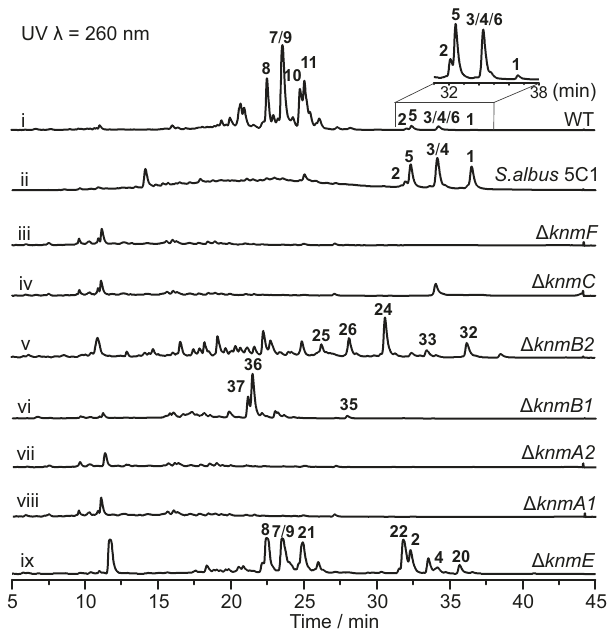
Fig. 2 | HPLC analysis of metabolic extracts from wild-type L. rhizosphaerae NEAU-A2 (i, magni fi ed region focuses on 1 – 6 ), heterologous expression strain S. albus 5C1 (ii) and mutant strains (iii-ix). Source data are provided as a Source Data fi